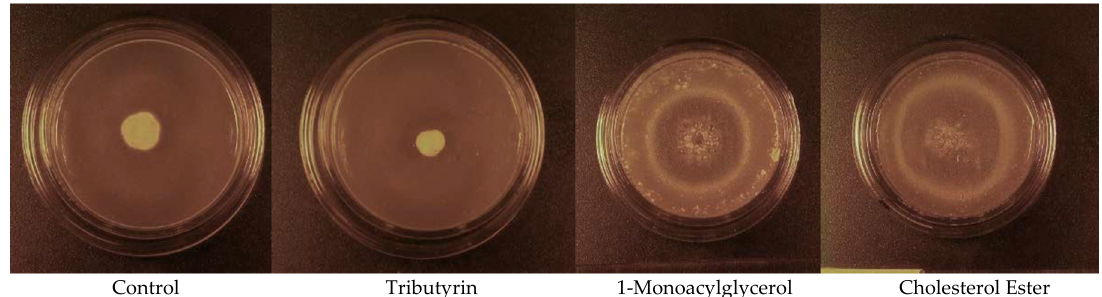
Figure 4. Photographs of Pseudogymnoascus destructans colonies after 19 d of growth at 12.7 °C in Experiment 6 on the control, 1.0% tributyrin, 1.0% 1-monoacylglycerol, and 1.0% cholesterol ester